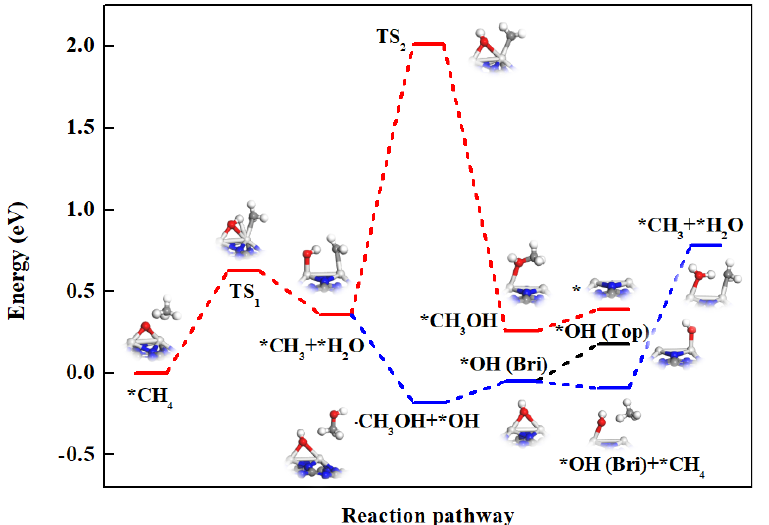
Figure 3. Reaction pathway of *O-assisted CH 4 decomposition on the Sc 2 -Pc monolayer. Blue, black, and red lines represent the three paths of *CH 3 reacting with *OH, *CH 3 reacting with · OH in solution, and the migration of *OH from bridge to top site,